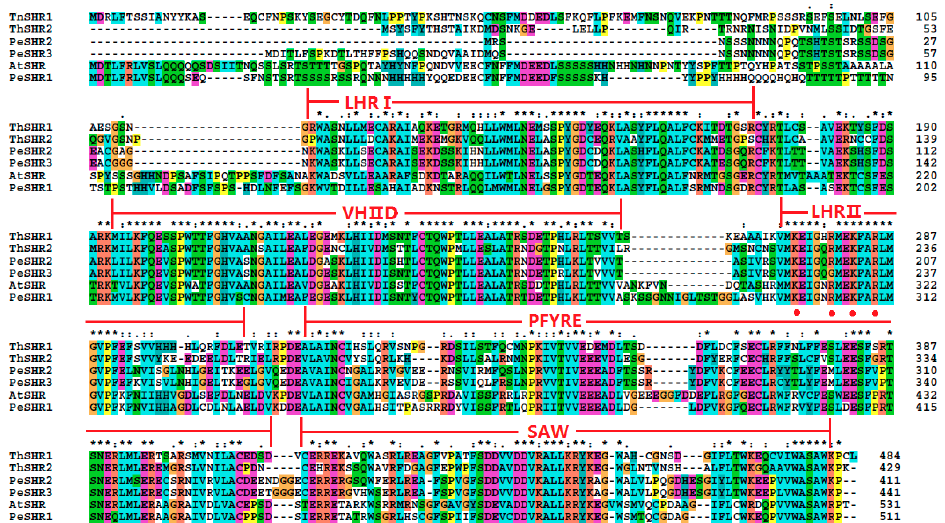
Figure 2. Alignment of the amino acid sequences of ThSHR1 and ThSHR2 with those of SHORT ROOT (SHR) of both Arabidopsis and Populus , using the ClustalW program. The highly-conserved region of the GRAS proteins can be divided into five recognizable motifs: the leucine heptad repeat I (LHR1), the VHIID motif, the leucine heptad repeat II (LHRII), the PFYRE motif and the SAW motif, as indicated above the sequence alignment. Amino acid position numbers are indicated to the right of the sequence. The putative nuclear localization signals were labeled with red points. The same below.